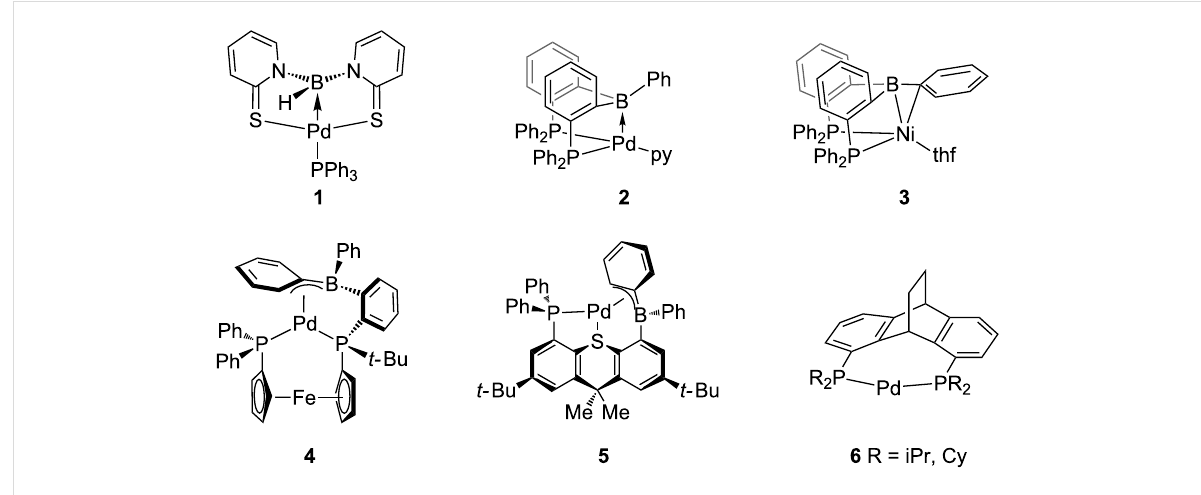
Figure 1: Selected M → B coordination modes 1 – 5 [6-10] and Hofmann’s Rucaphos complex 6 [11].